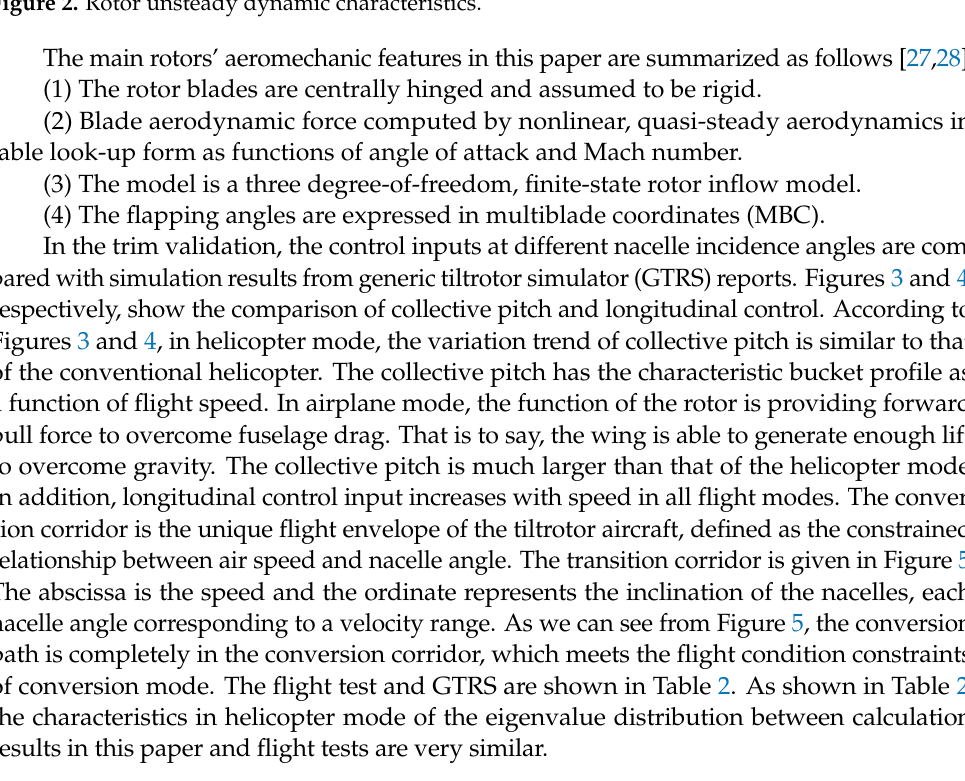
Figure 2. Rotor unsteady dynamic